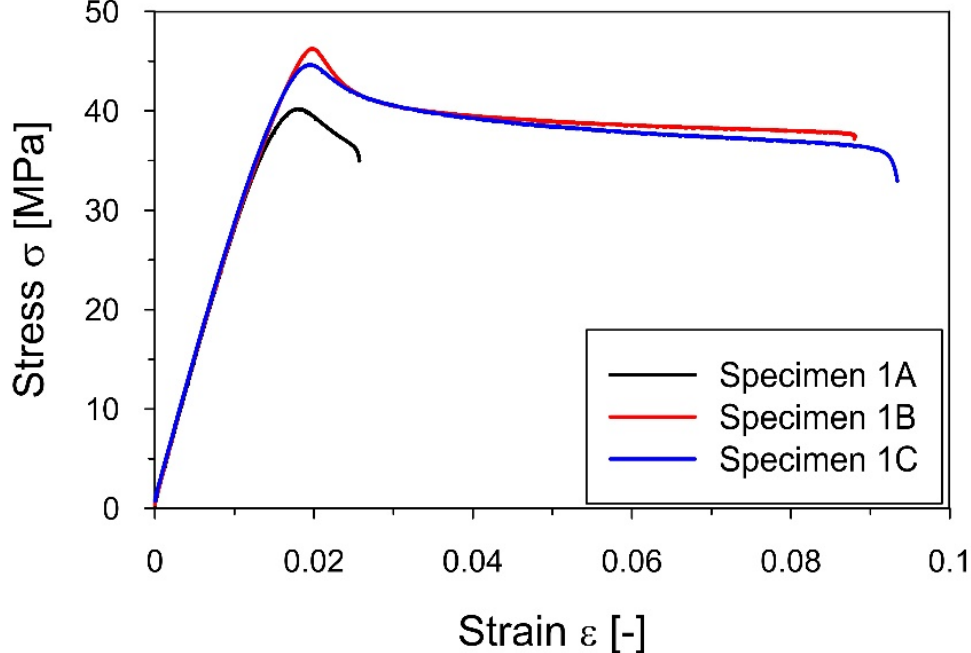
Figure 8. The strain − stress curves for A1, B1, and C1 specimens obtained from the tensile static test that served to determine the yield point of the PLA-IMPACT material.